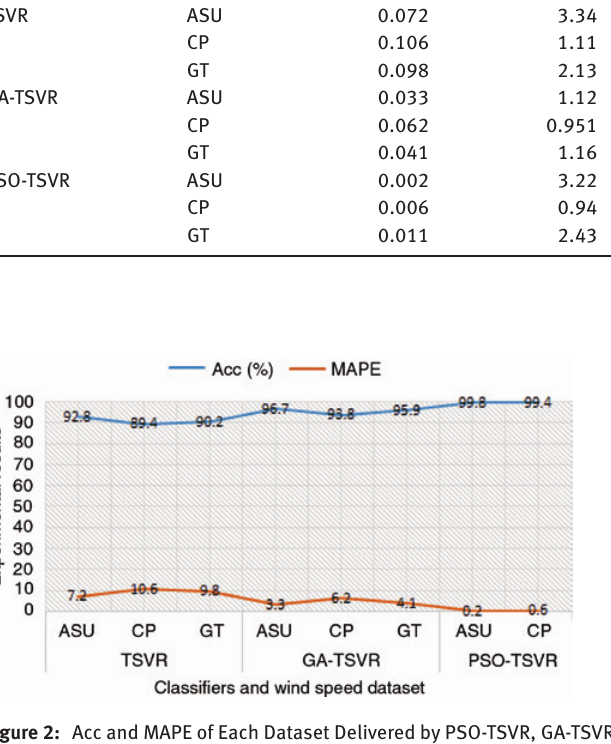
Figure 2: Acc and MAPE of Each Dataset Delivered by PSO-TSVR, GA-TSVR, and